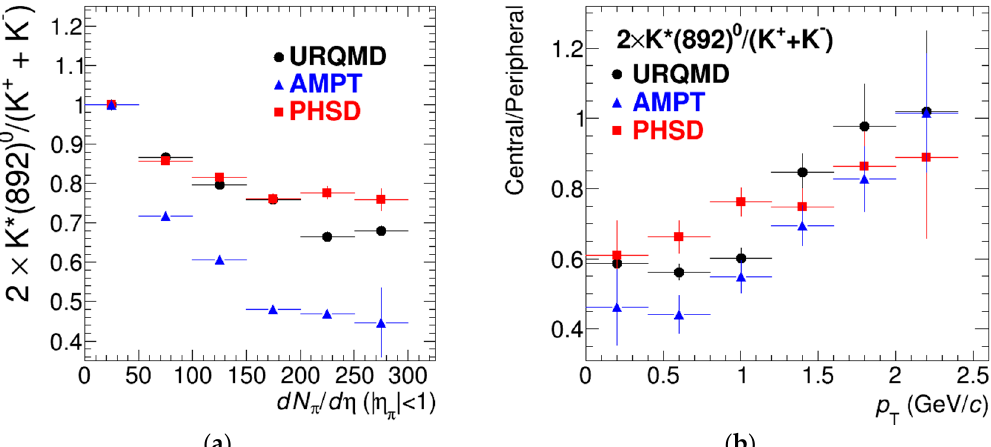
Figure 6. Ratios K * (892) 0 /K predicted by UrQMD [11], PHSD [12] and AMPT [13] event generators in Au+Au collisions at √ 𝑠 𝑁𝑁 = 11 GeV. The K*(892) 0 /K ratios normalized to unity in most peripheral collisions are shown as a function of the final state charged ‐ particle multiplicity ( a ), and the (K * (892) 0 /K) central /( K*(892) 0 /K) peripheral double ratio is shown as a function of the transverse particle momentum ( b ).